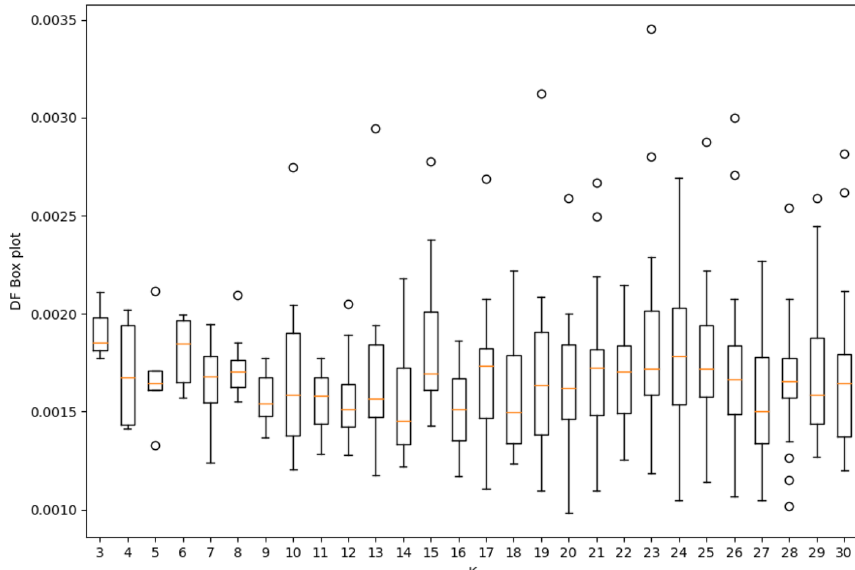
Fig. 13 Box diagram of cross-validation